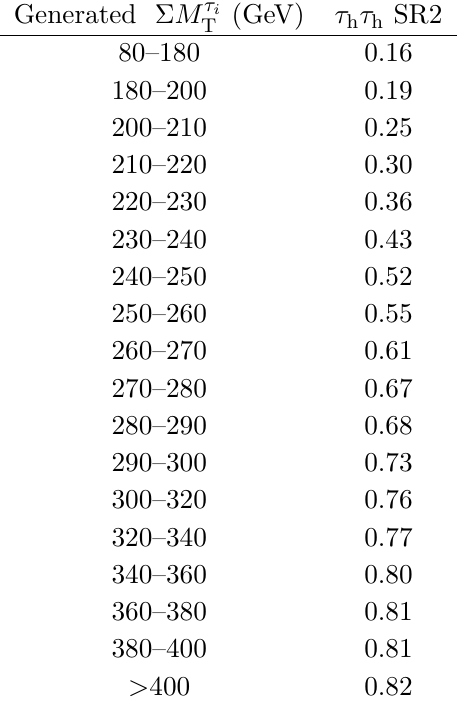
requirement in (cid:28) h (cid:28) h SR2 versus the generated (cid:6) M (cid:28) i T